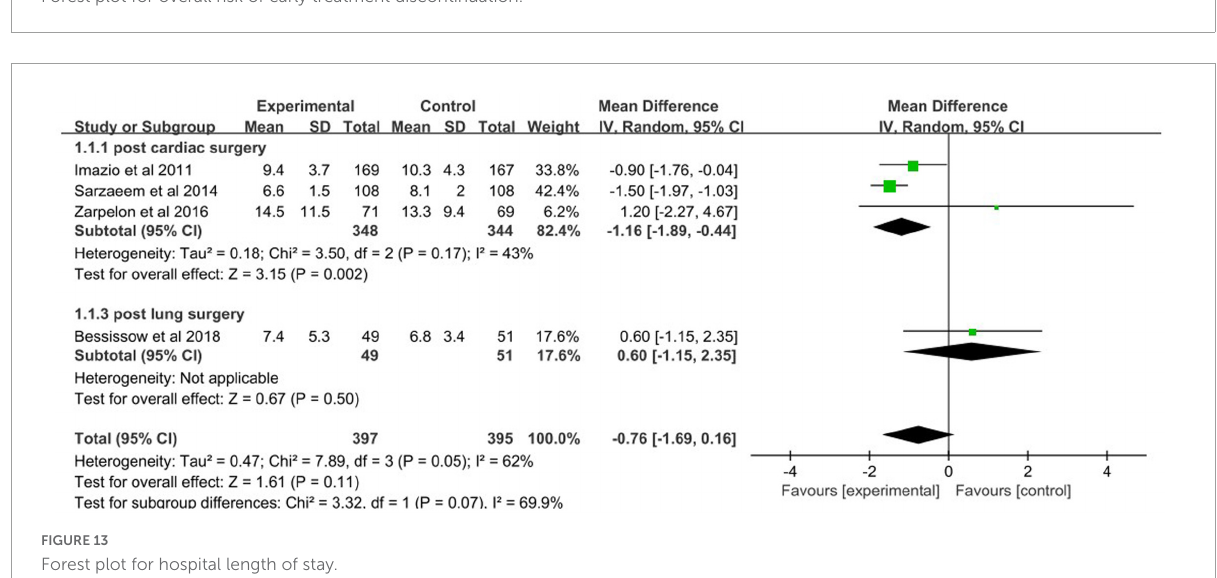
FIGURE12 Forest plot for overall risk of early treatment discontinuation.